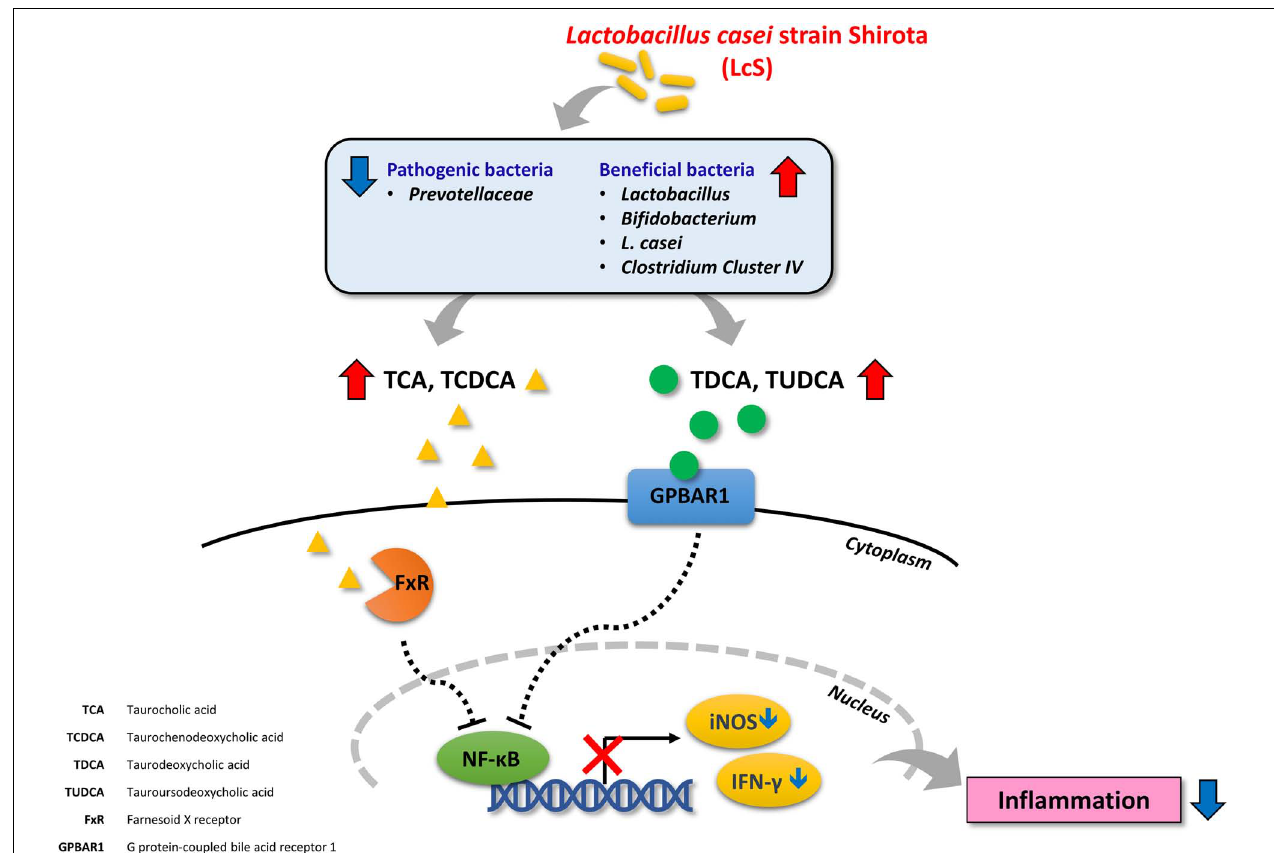
FIGURE 7 | Overview of the proposed anti-inflammatory mechanism of LcS in